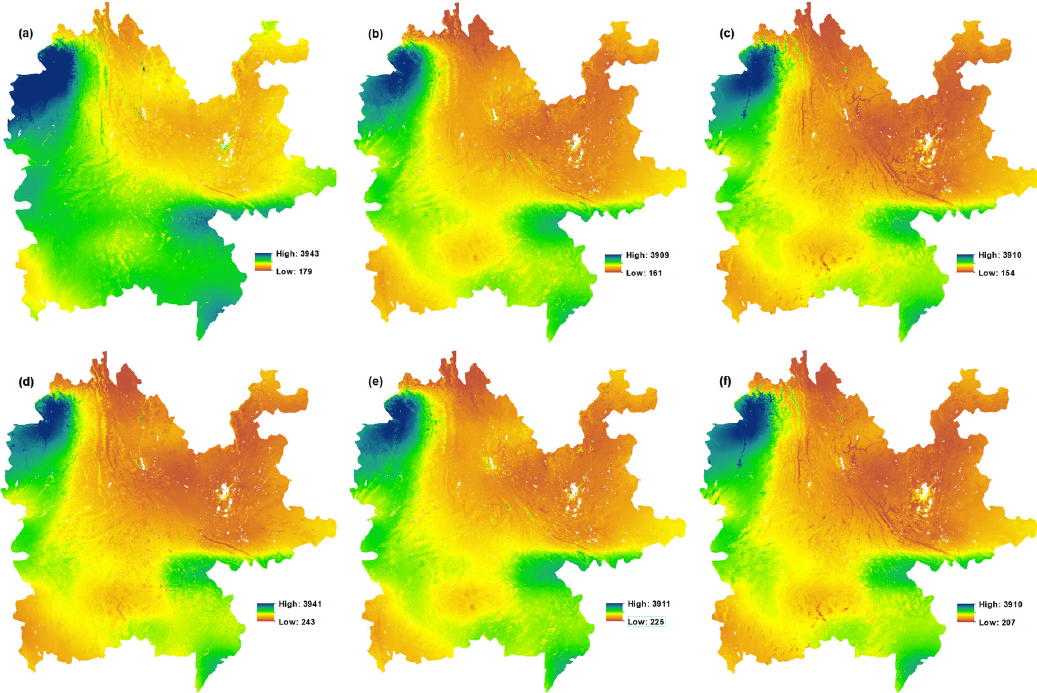
Figure 8. The fine precipitation before residual correction (NDVI ( a ), EVI ( b ), and LAI ( c )) and after residual correction (NDVI ( d ), EVI ( e ), and LAI ( f )) for the year 2018. Blank spots represent masked areas (e.g., urban and built-up, water bodies, and NDVI / EVI / LAI <